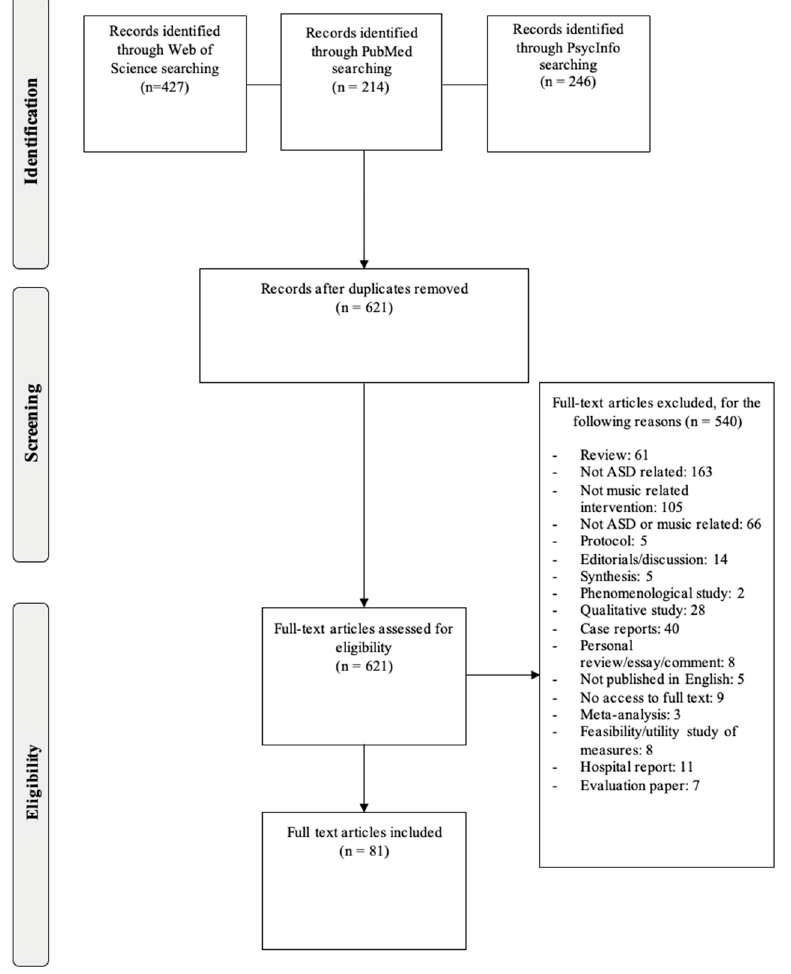
Figure 1. Flow-chart of literature search according to PRISMA.